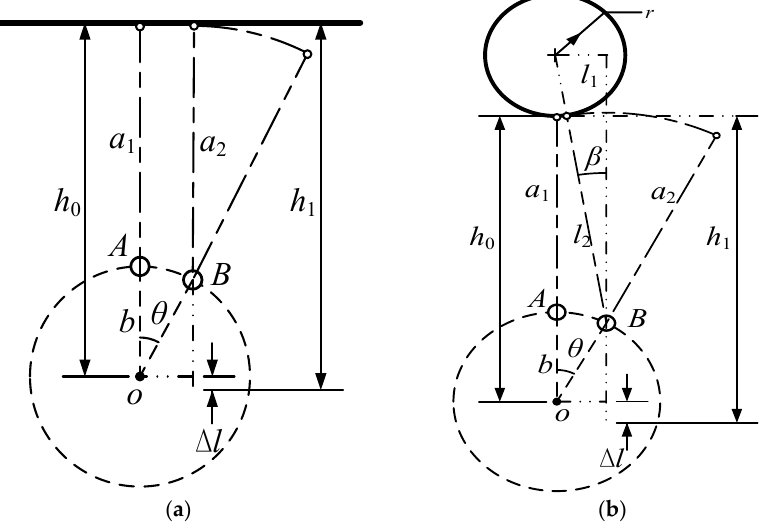
Figure 4. Geometric compensator model. ( a ) Flat model; ( b ) cylinder model.